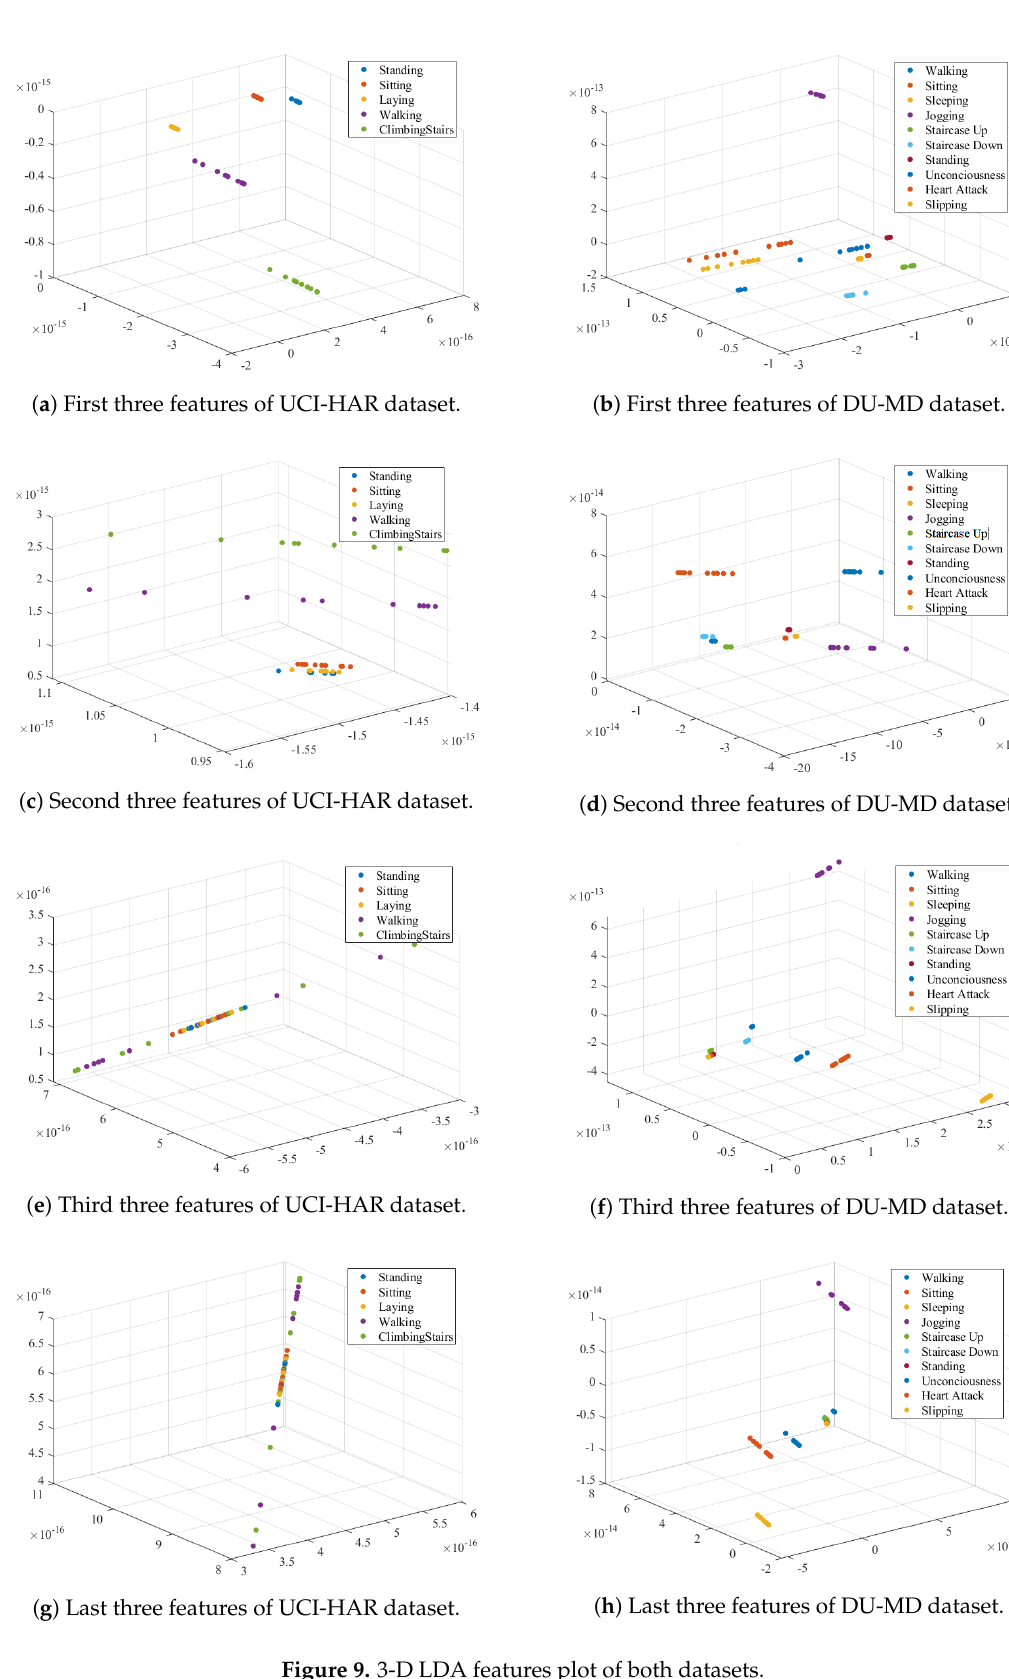
Figure 9. 3-D LDA features plot of both